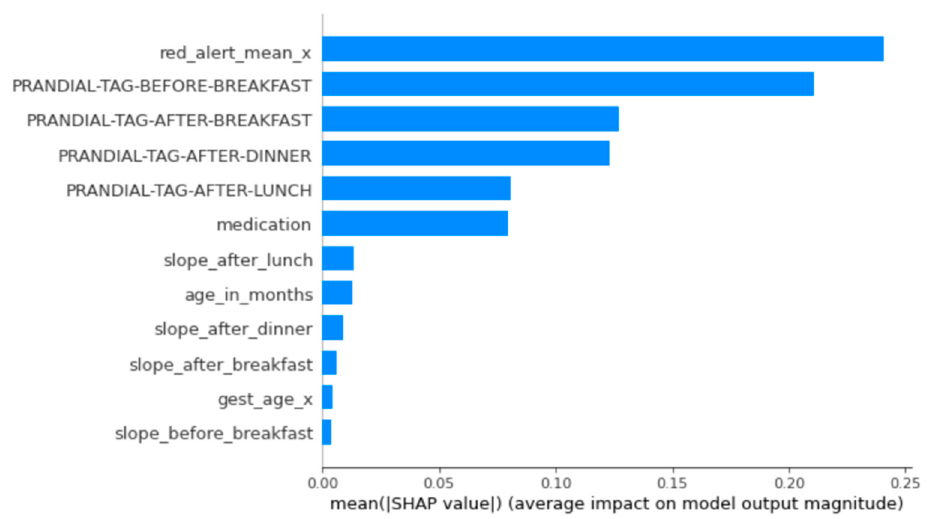
Figure A7. SHAP feature importance ranking for model trained on Tags, High-Readings, and EHR features.